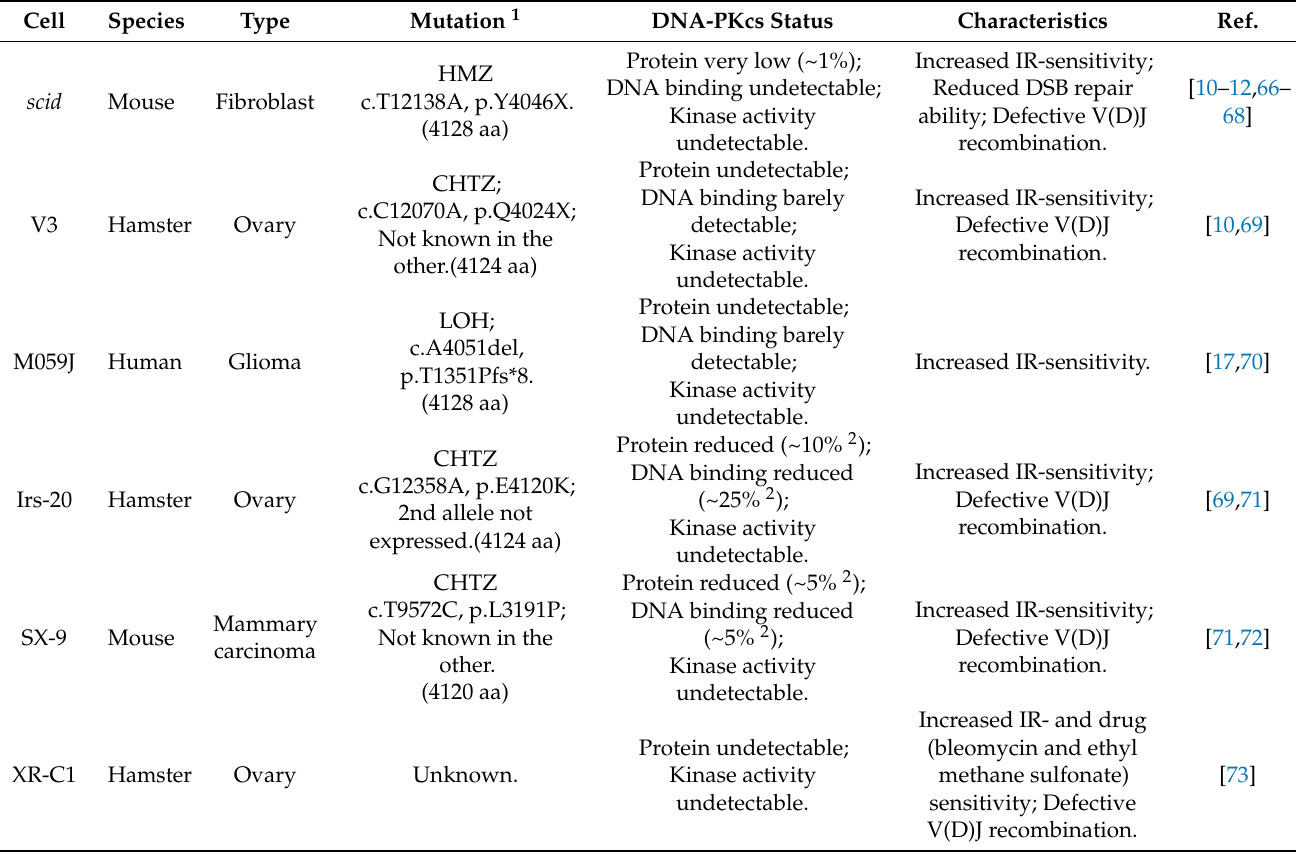
Figure 2. Simplified diagram of DSB repair through NHEJ. Table 1. DNA-PKcs-deficient cell